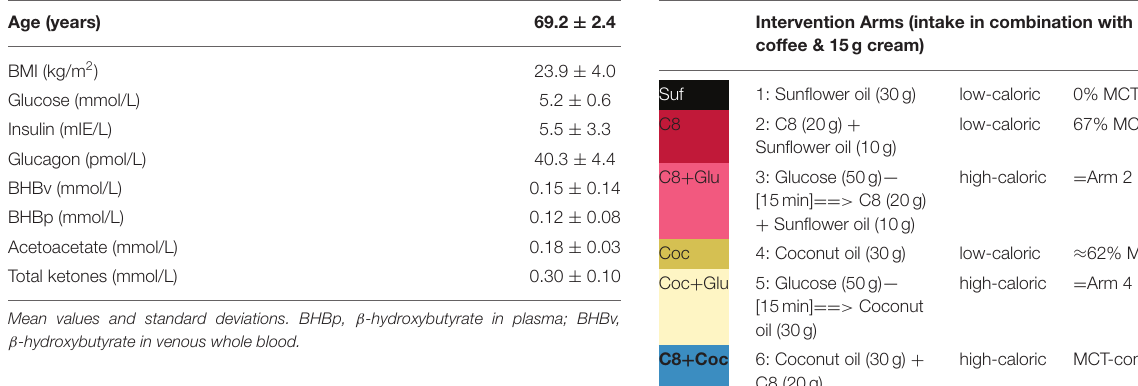
TABLE 1 | Characteristics of the participants. TABLE 2 | Description of the intervention arms, and introduction of